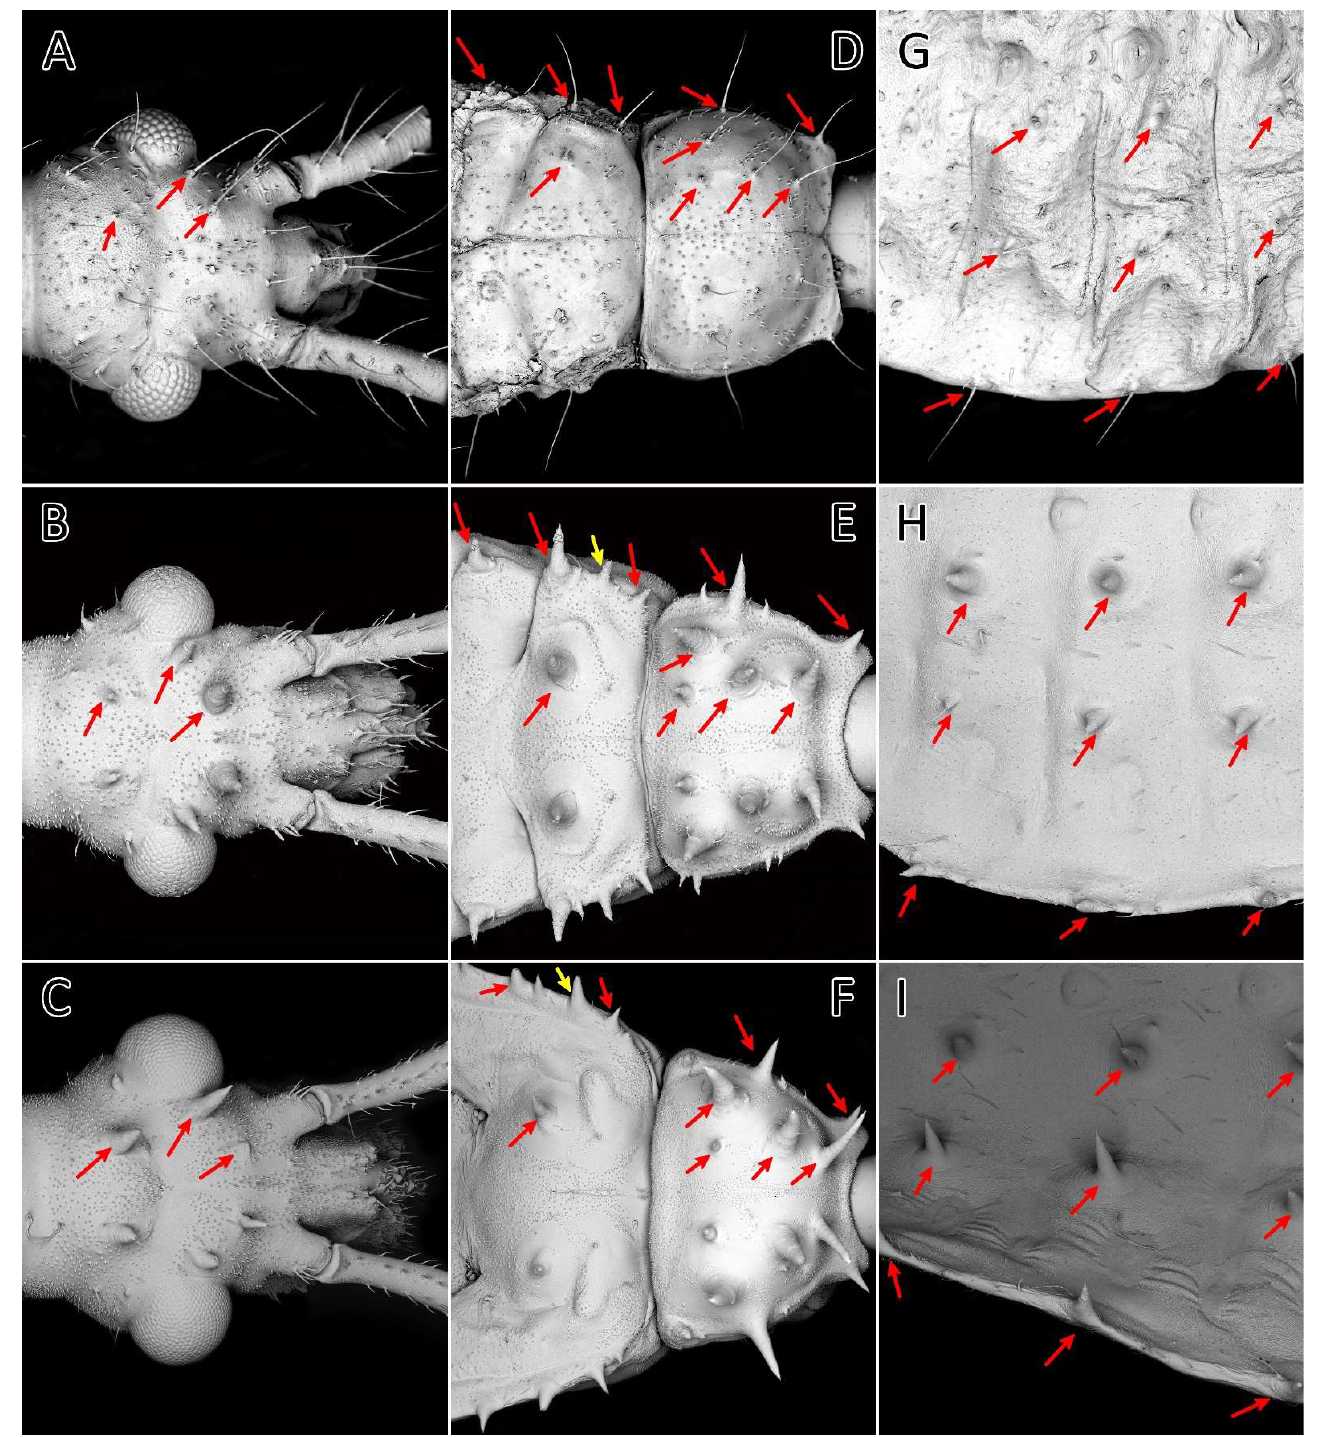
Figure 15. First ( A , D , G ), third ( B , E , H ), and fifth ( C , F , I ) instars of Psyttala horrida (Stål, 1865), SEM views. Long setae and corresponding spine-like processes on the dorsal side of the ( A – C ) head, ( D – F ) thorax, and ( G – I ) abdomen. The arrows indicate the corresponding appendages at the following stages.